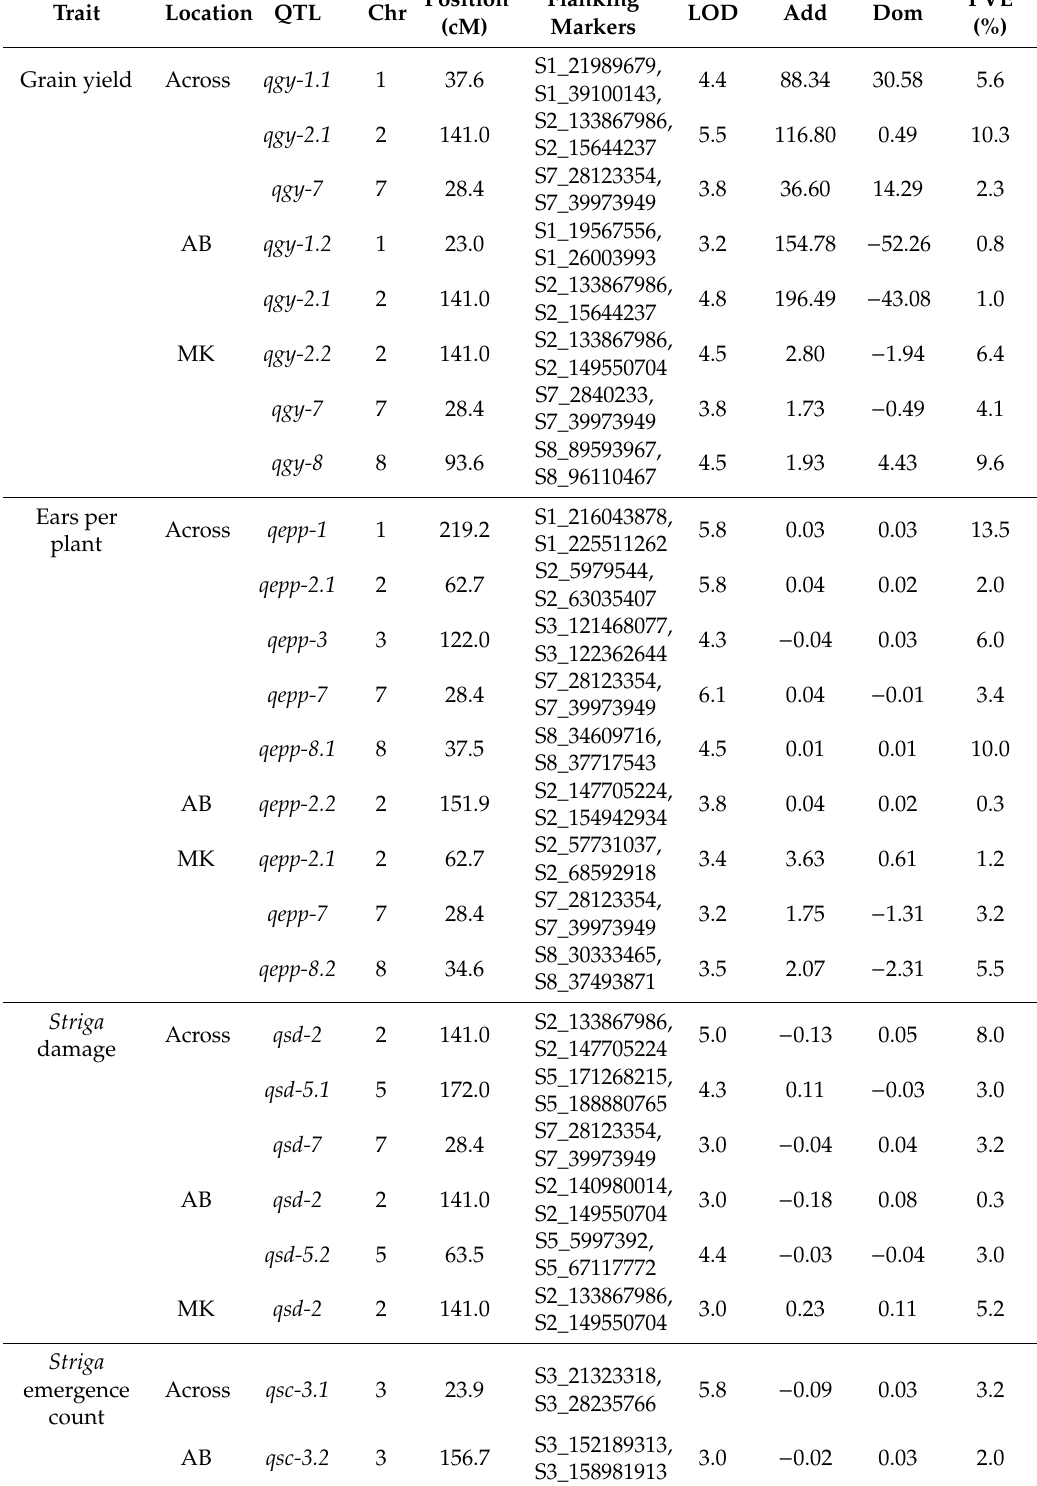
Table 3. Summary of quantitative trait loci (QTLs) mapped in the F 2:3 population derived from TZEEI 79 × TZdEEI 11 under artificial Striga